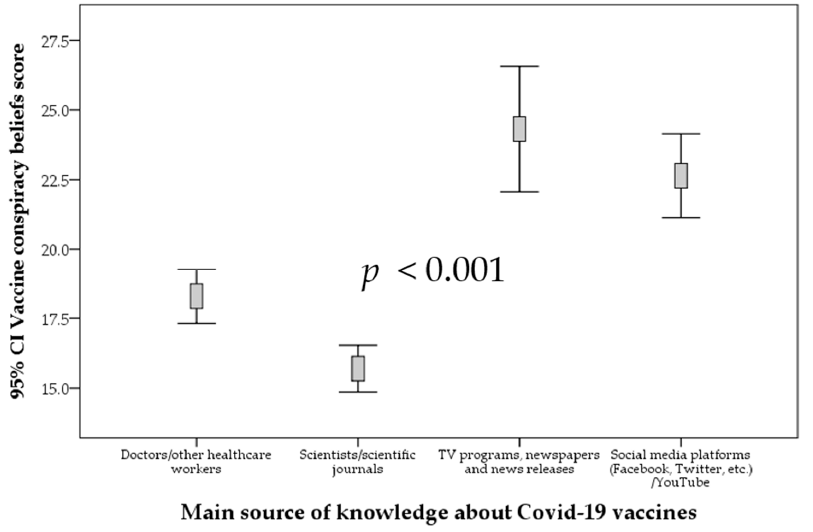
Figure 8. The correlation between vaccine conspiracy belief scale and the main source